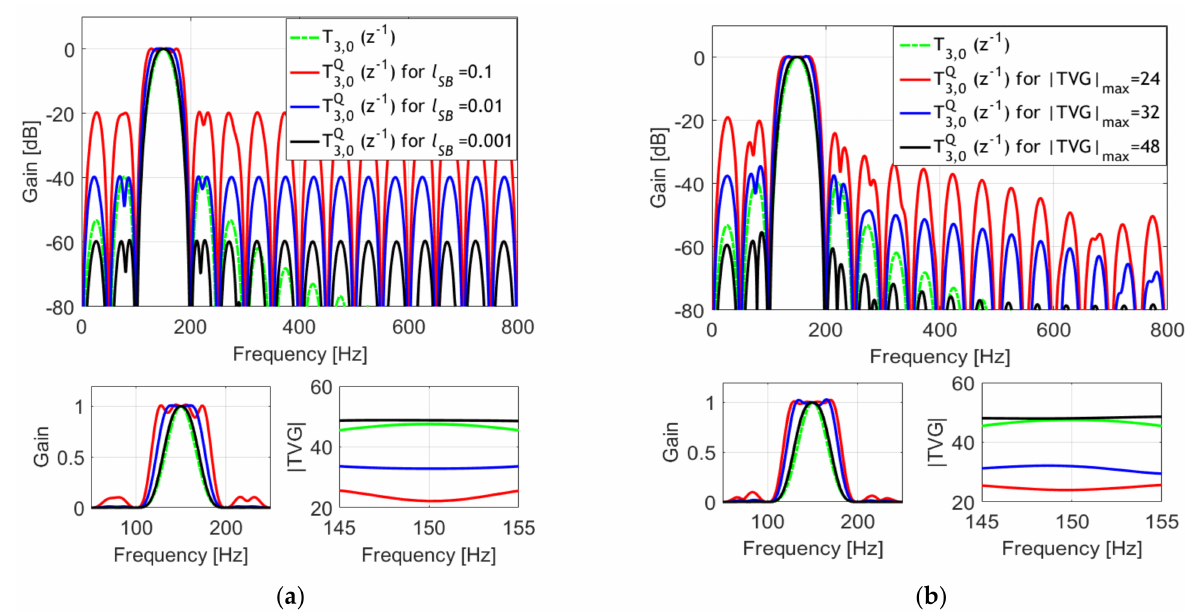
(cid:0) (cid:1) z − 1 ) and reshaped ( T Q